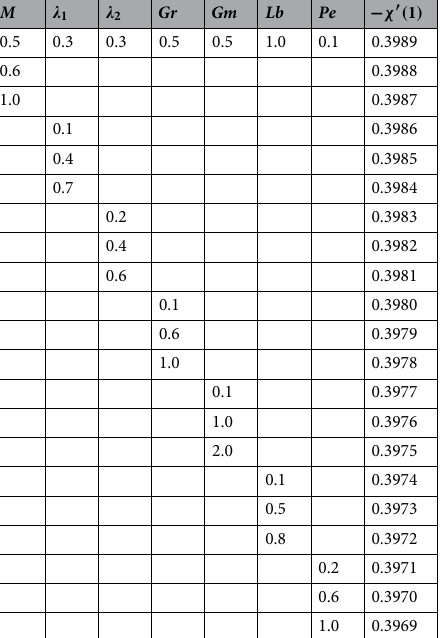
χ ′ ( 1 ) for M , (cid:31) 1 , (cid:31) 2 , Gr , Gm , Lb and Pe −